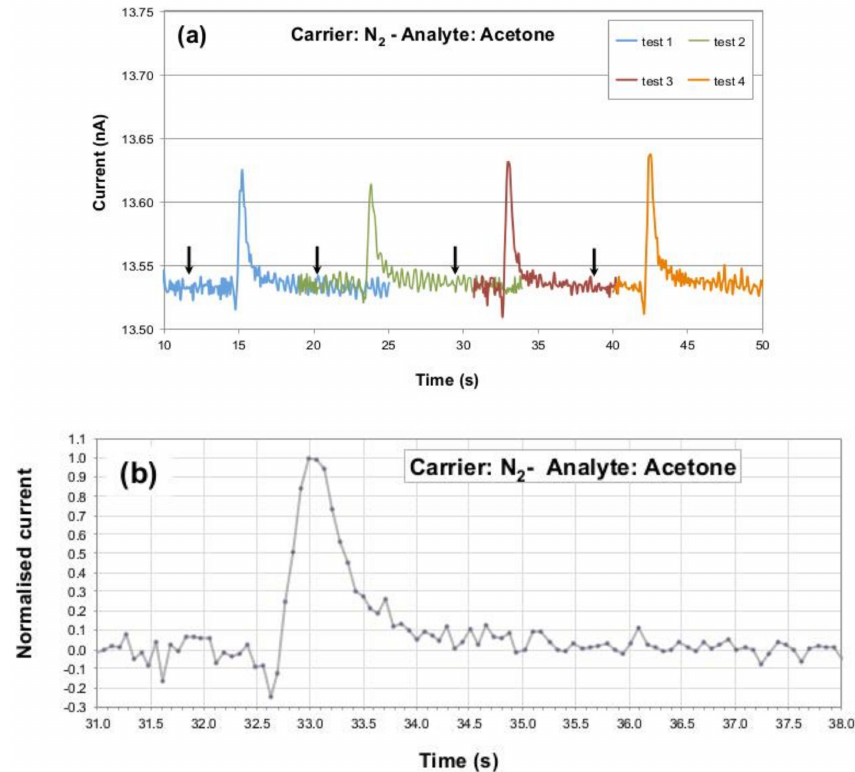
Figure 3. ( a ) Repeated tests for P3HT nanofibers sensors against 3.5 ppm of acetone in nitrogen